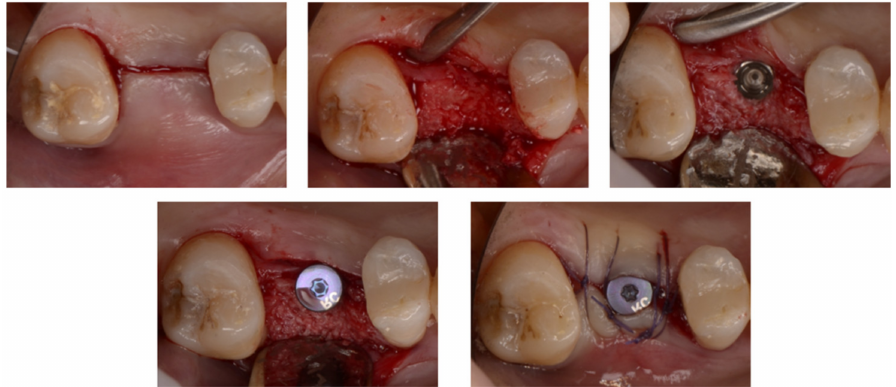
Figure 10. Fixture placed in the regenerated ridge, healing abutment in place and buccal repositioning of the keratinized gingiva.